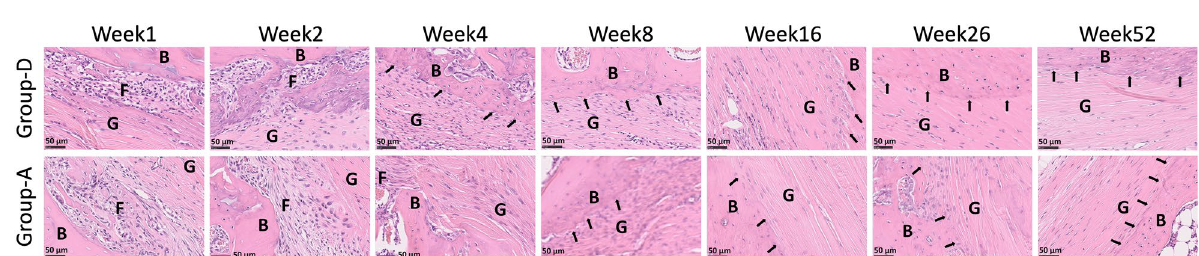
Figure 4. Representative hematoxylin–eosin staining images of the graft–tibial tunnel interface in groups D and A taken at various time points; the black arrow indicates a Sharpey-like fiber. B bone, T tendon, F fibrous tissue, group D decellularized bovine tendon graft, group A autologous tendon